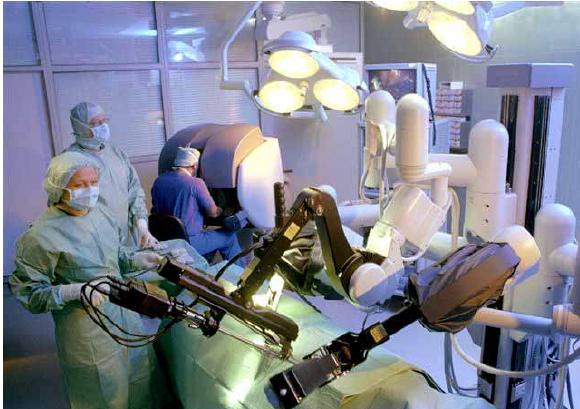
Figure 3. An example of application of robotics in surgery of transplantation (the robot provides a high precision in surgical procedures and allows a significant reduction of time cost).